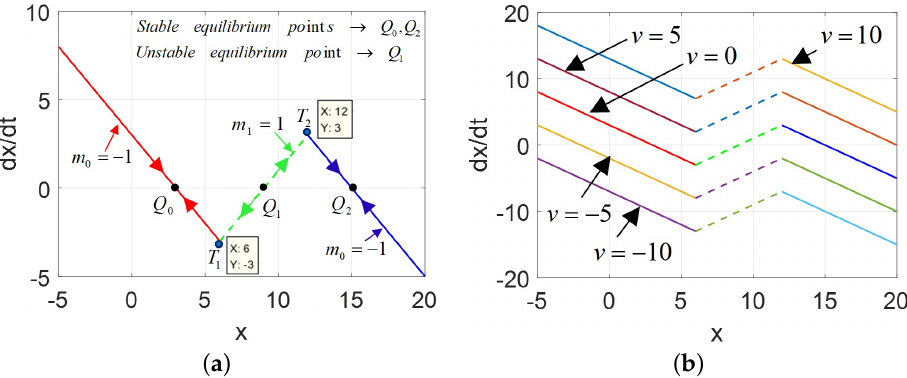
Figure 2. DRM of the proposed model, A = A M : ( a ) the DRM for v = 0 V (power-off plot), ( b ) the DRM for v = 0 V, ± 5 V, ± 10 V.